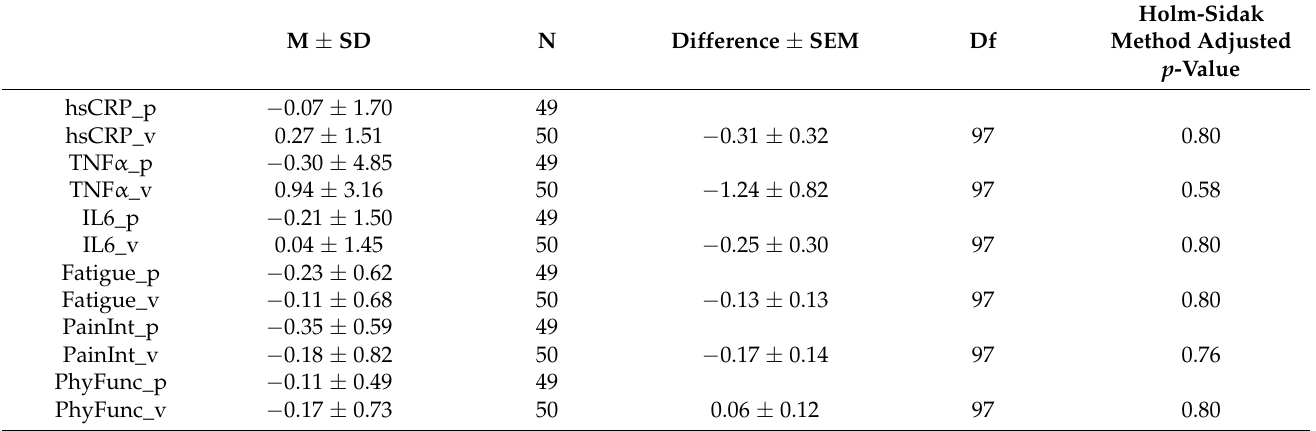
Table 2. Crossover Group Analysis.